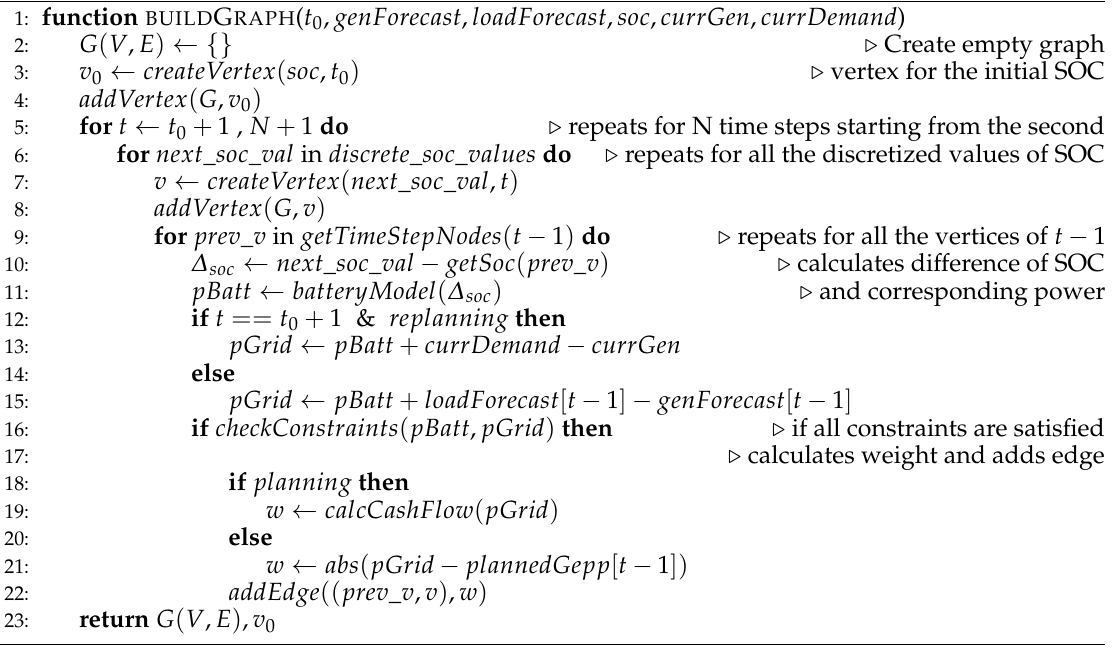
Algorithm 1 Pseudo-code of graph building function. It builds a graph such as the one in Figure 3.